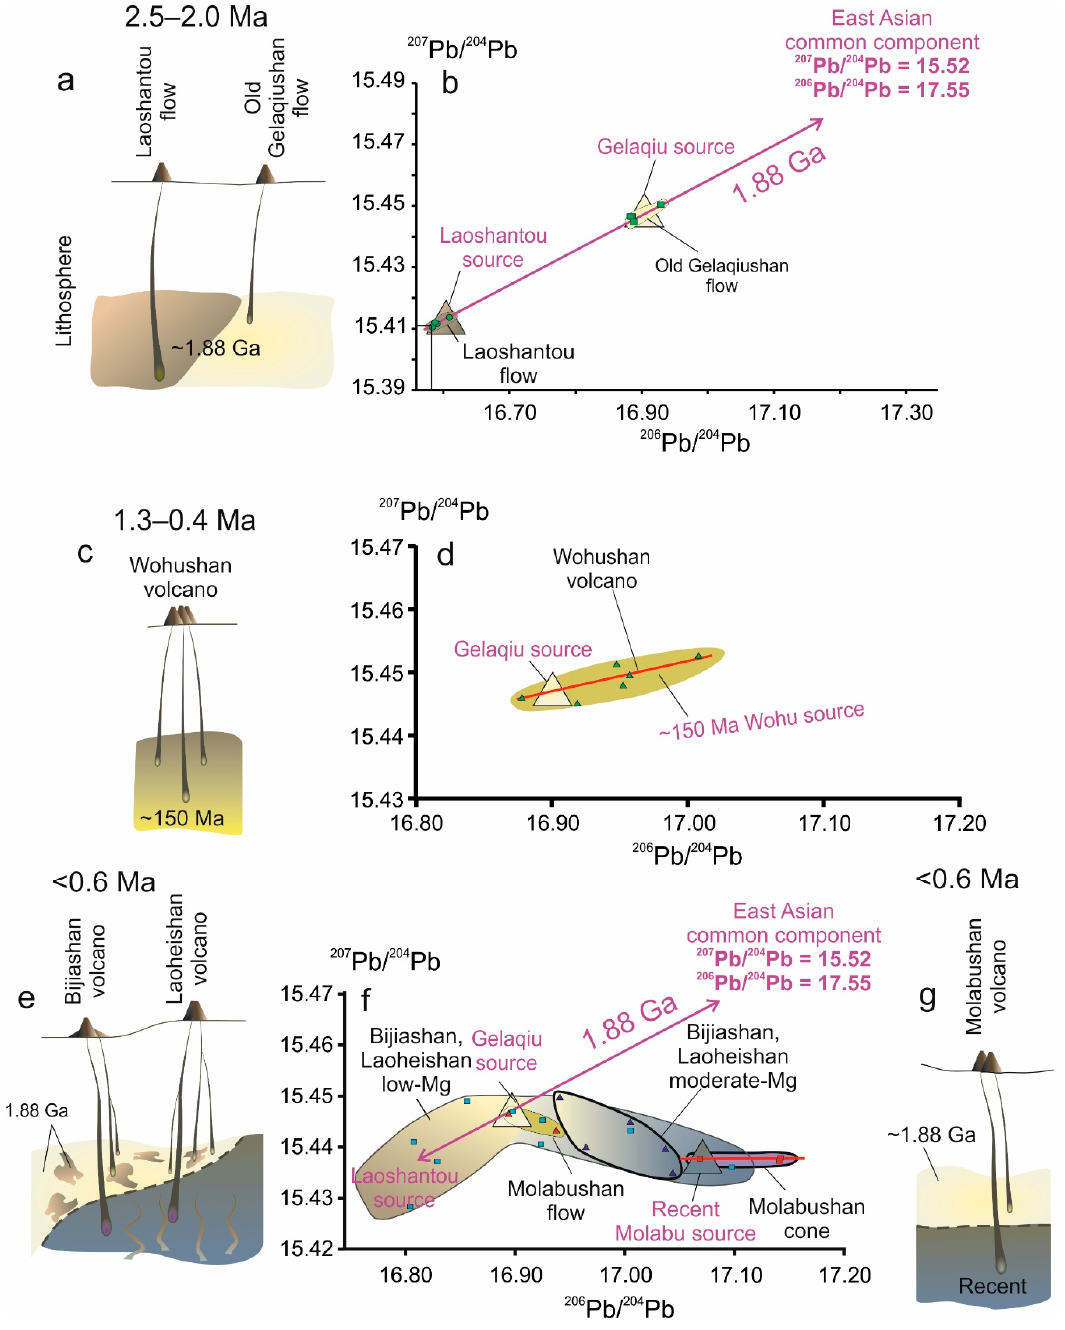
Figure 9. Illustrations of sources and diagrams 207 Pb/ 204 Pb versus 206 Pb/ 204 Pb of potassic lavas from the Wudalianchi volcanic field: ( a , b ) — Laoshantou and old Gelaqiushan flows, ( c , d ) — Wohushan volcano, ( e–g ) — Bijiashan, Laoheishan, and Molabushan volcanoes. In diagram b, calculation of the secondary isochron 1.88 Ga was performed using the Isoplot program [87]. Modified after [40]. Similar to volcanic rocks of the Changbai and Wudalianchi volcanic fields, those of the